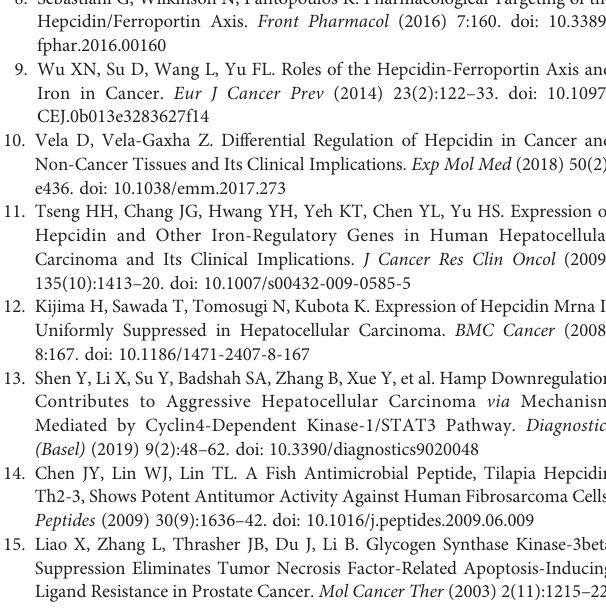
Supplementary Figure 1 | Hepcidin gene is predominantly expressed in normal liver tissues. Hepcidin expression pro fi les were assessed with two databases (35, 60) on the Oncomine ™ platform (18). These two datasets contained 123 (35) and 504 (60) samples, respectively. The cDNA microarray was conducted using the Human Genome U133 Plus 2.0 array of 19574 genes in the Roth dataset (60). There were 14430 measured genes in the Shyamsundar dataset (35). Supplementary Figure 2 | Hepcidin gene expression is positively associated with iron regulation-related genes. The correlation of hepcidin gene expression with the whole transcriptome was analyzed using the TCGA dataset on the XIANTAO platform. The top 596 correlated genes with hepcidin expression (Spearman rho > 3.0 with q value < 0.05) were used for gene enrichment analysis on the KOBAS platform.DatavisualizationforKEGGpathwayswascarriedoutbasedontheEnrich ratio (left panel) and -log 10 [p value] (right